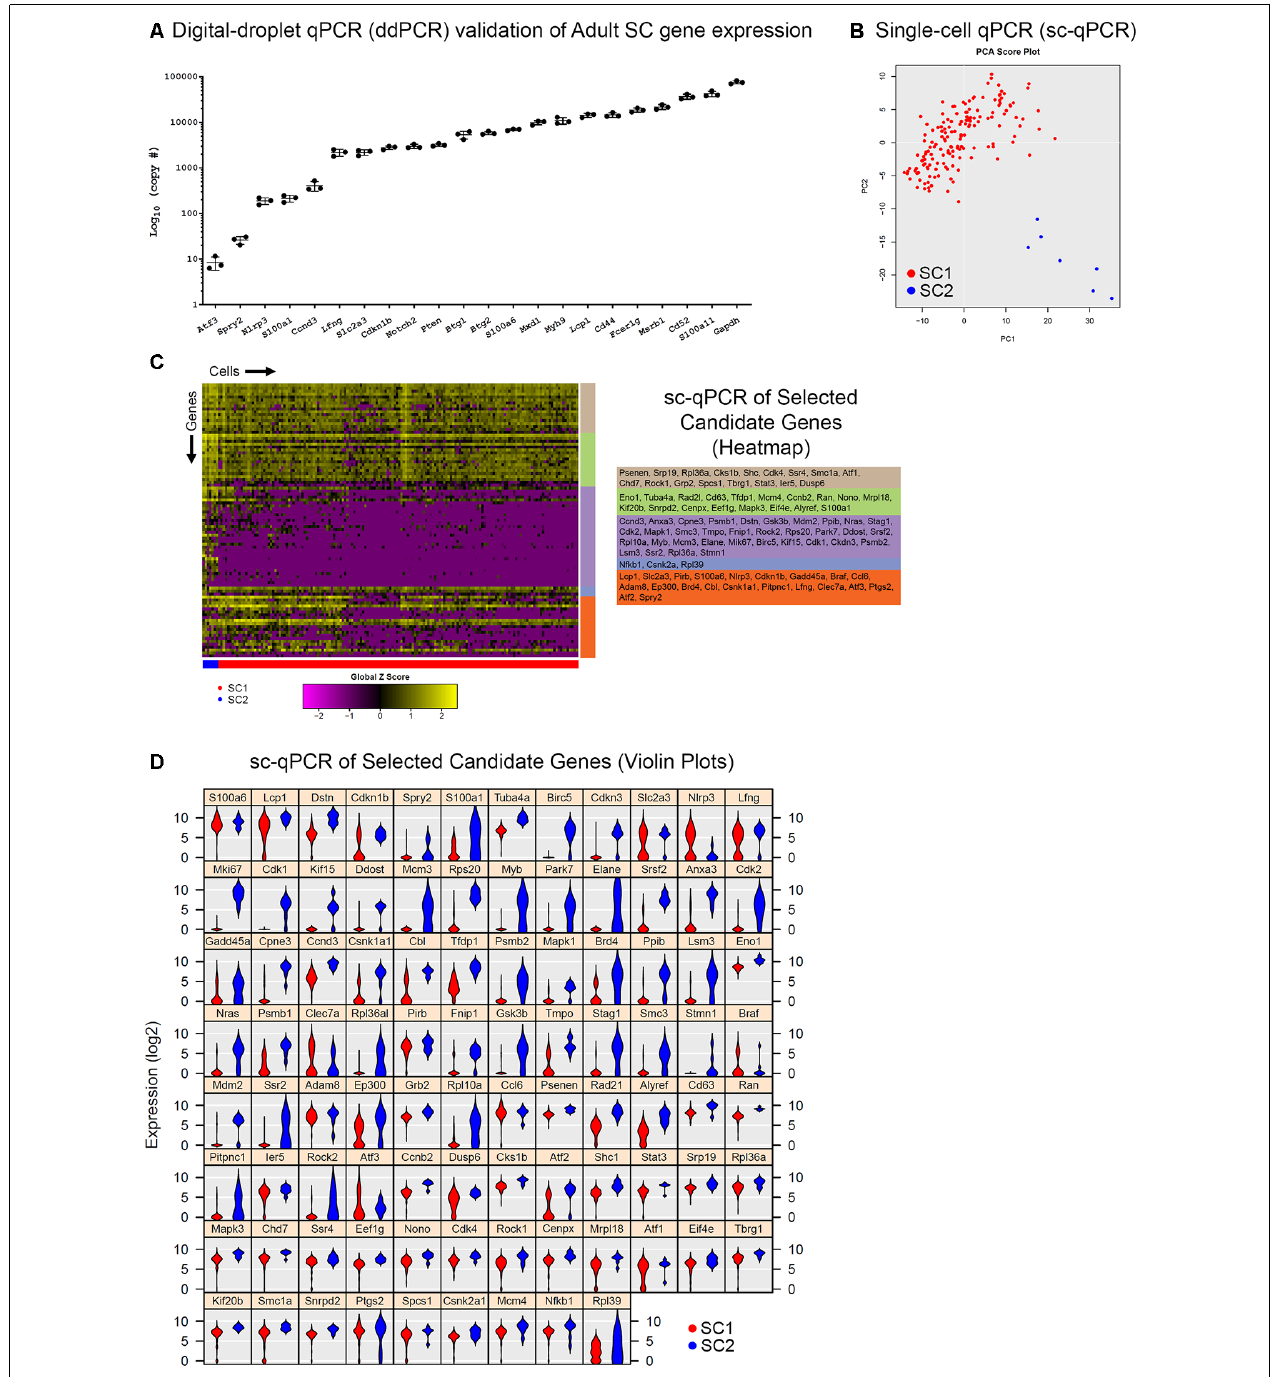
FIGURE 4 | Digital droplet PCR (ddPCR) and single-cell quantitative polymerase chain reaction (qPCR) analyses of additional transcripts validate adult cochlear SC scRNA-Seq. (A) Digital droplet PCR (ddPCR) quantification of candidate genes in FACS-purified P60 Lfng EGFP -positive cochlear SCs. Absolute quantitation measured in a number of transcript copies detected are plotted on the log base 10 scale on the vertical axis and genes of interest are on the horizontal axis. All candidate genes were detected indicating expression in FACS-purified adult cochlear SCs. (B) Principal component analysis (PCA) of single-cell qPCR (sc-qPCR) of 170 FACS-purified P60 Lfng EGFP -positive cochlear SCs corroborates unbiased clustering of single-cell transcriptomes into two clusters (SC1 in red, SC2 in blue). (C) Heatmap of sc-qPCR results with 170 adult cochlear SCs (along the horizontal axis) and 93 candidate genes (along the vertical axis). Candidate gene clusters as determined by hierarchical clustering are noted as the colored bars along the vertical axis of the heatmap. Candidate genes making up the gene clusters are noted to the right of the heatmap in the corresponding colored boxes. As denoted by the expression histogram, the higher the expression, the more yellow the box corresponding to the gene in a given cell. (D) Violin plot display of sc-qPCR results demonstrates candidate gene expression levels in adult cochlear SCs.